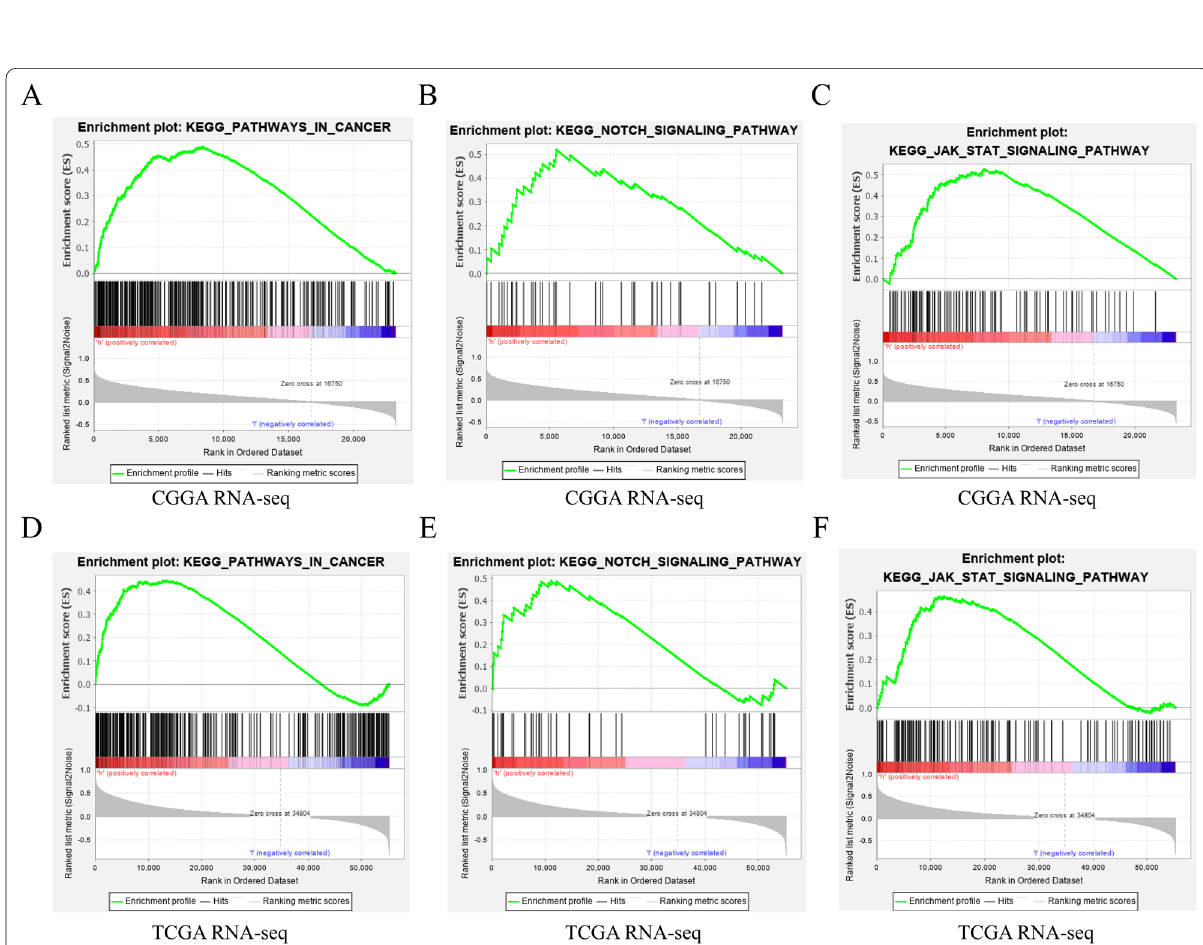
Fig. 7 The GSEA analysis results of the CGGA RNA-seq and TCGA RNA-seq data. A Pathway in cancer (CGGA RNA-seq); B Notch signaling pathway (CGGA RNA-seq); C JAK-STAT signaling pathway (CGGA RNA-seq); D Pathway in cancer (TCGA RNA-seq); E Notch signaling pathway (TCGA RNA-seq); F JAK-STAT signaling pathwaypathway in cancer (TCGA